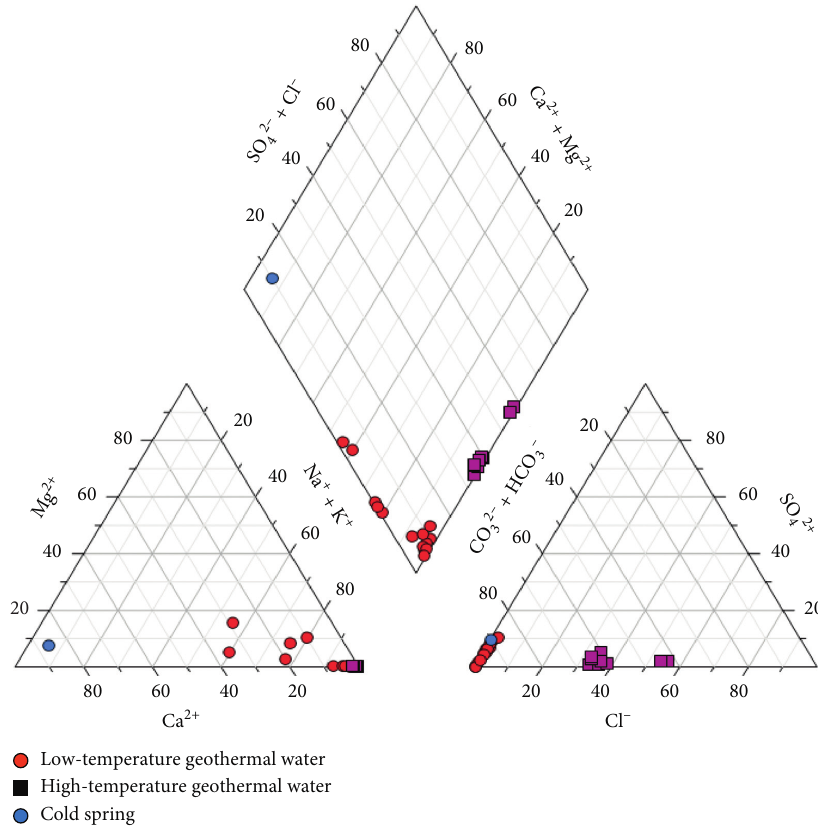
Figure 3: Piper plot of water samples [34]. Low-temperature geothermal waters and cold spring are from this study. High-temperature geothermal waters are from [23]. Table 2: Saturation indices of different minerals in geothermal